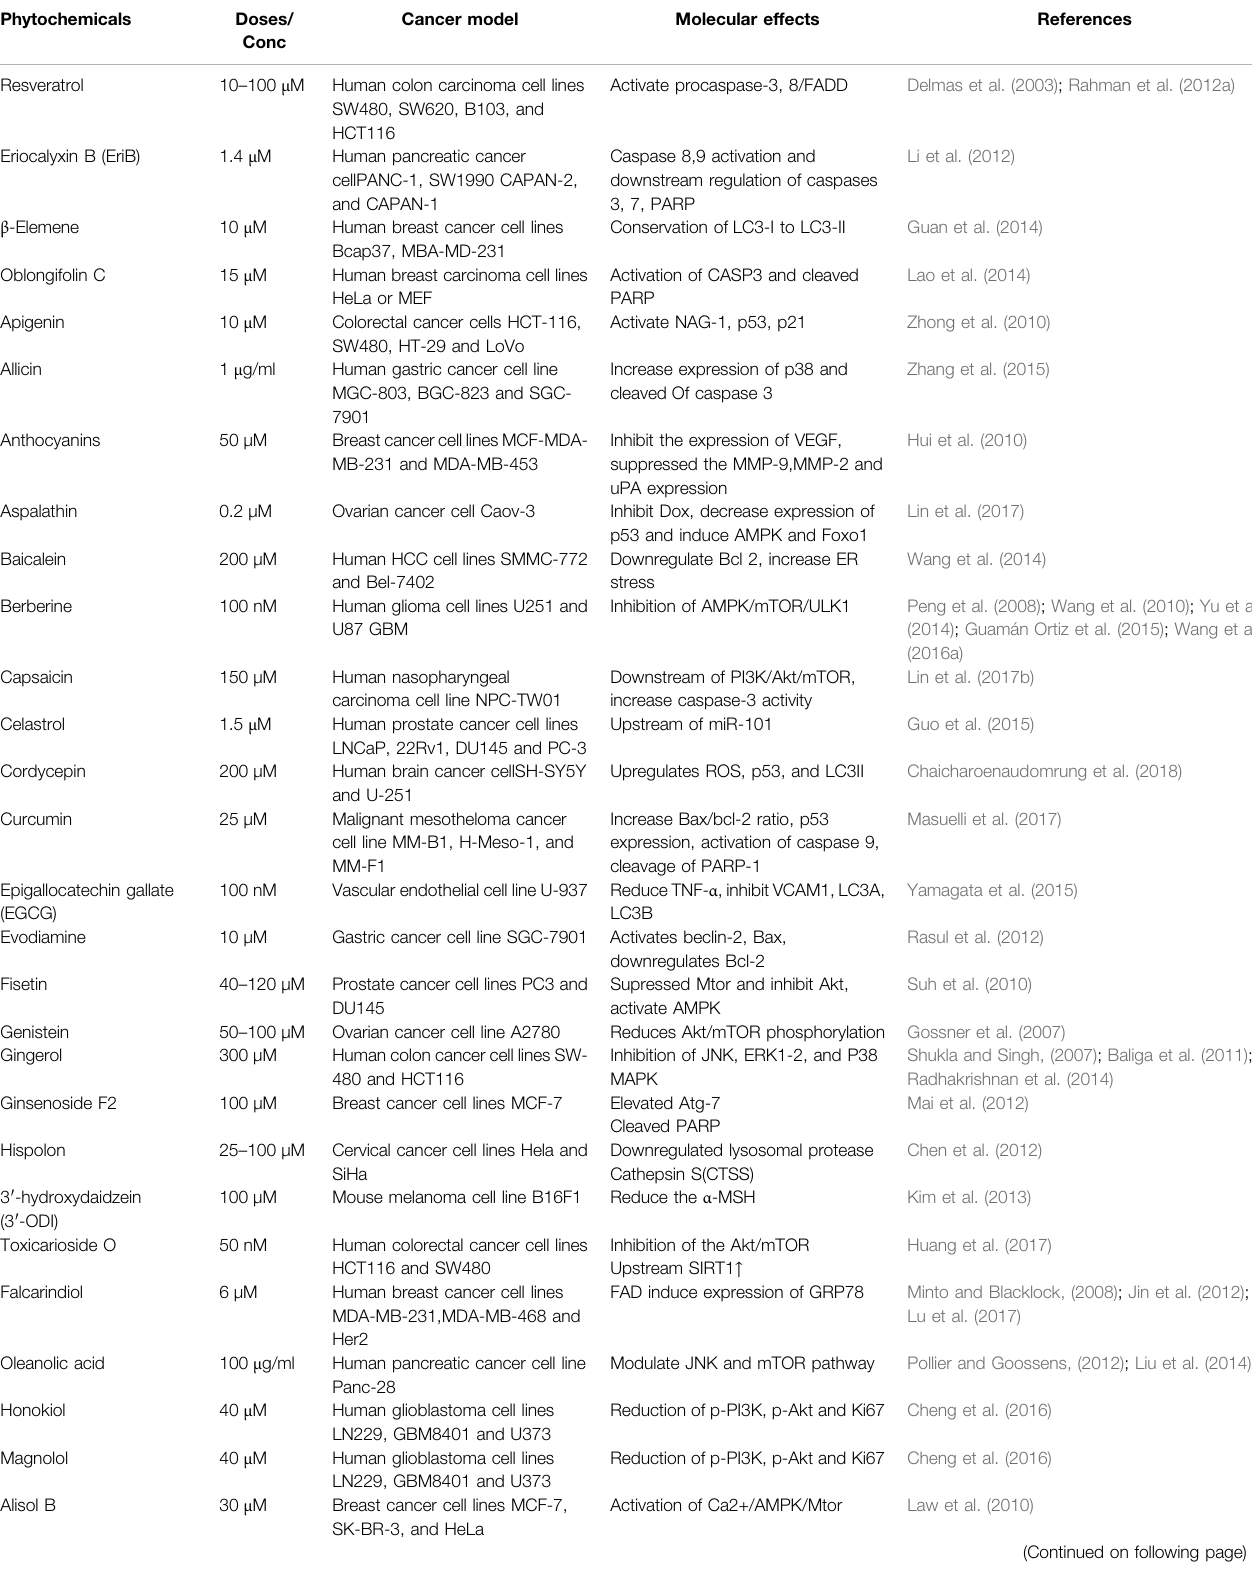
TABLE 1 | Phytochemicals that activate autophagy and apoptosis in various in vitro and in vivo cancer models.